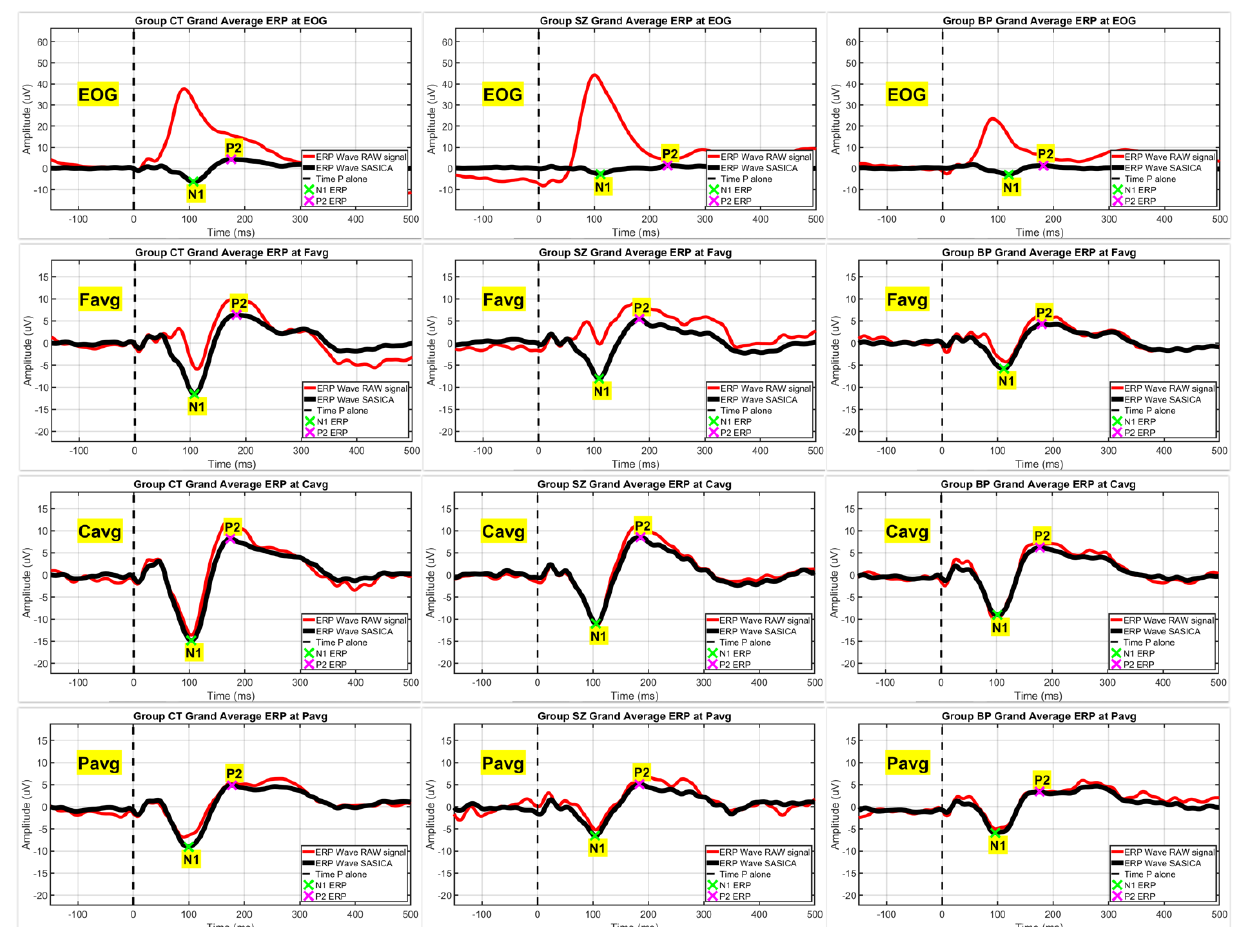
Figure 3. Grand averaged waveforms of all groups before (red line) and after (black line) artifacts’ removal on the EOG electrode and on the average of frontal (Favg), central (Cavg) and parietal (Pavg) channels (lines of subfigures). After artifact’s removal, the N1 and P2 ERPs (green and magenta crosses, respectively) were identified even on the EOG channel, due to the underlying brain activity captured by this electrode, visible only after complete removal of eye-blinks.